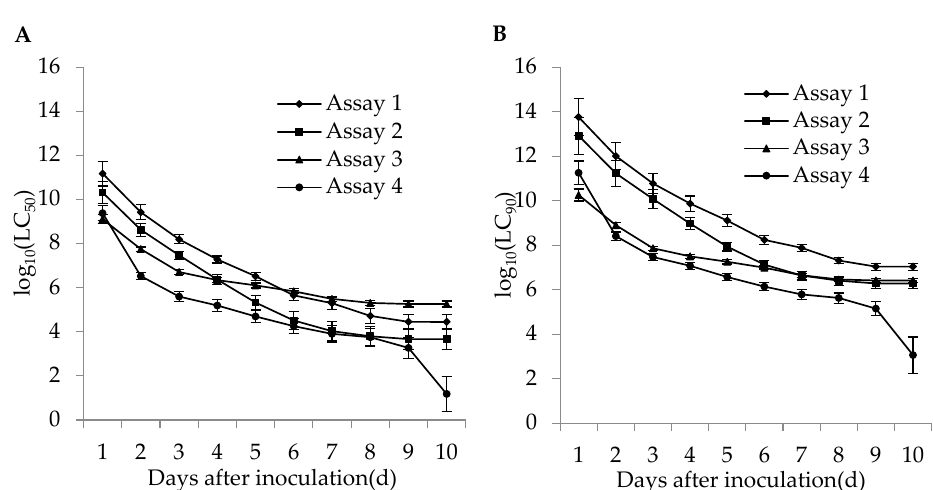
Figure 5. Curve trends in the logarithmic estimates of LC 50 ( A ) and LC 90 ( B ) (bars: SE) for assays 1 ( M. flavoviride applied at 1.2 × 10 6 and 1.2 × 10 8 conidia/mL alone), 2 ( M. flavoviride applied at 1.2 × 10 6 and 1.2 × 10 8 conidia/mL integrated with DE), 3 ( M. flavoviride applied at 1.2 × 10 6 and 1.2 × 10 8 conidia/mL integrated with imidacloprid), and 4 ( M. flavoviride applied at 1.2 × 10 6 and 1.2 × 10 8 conidia/mL